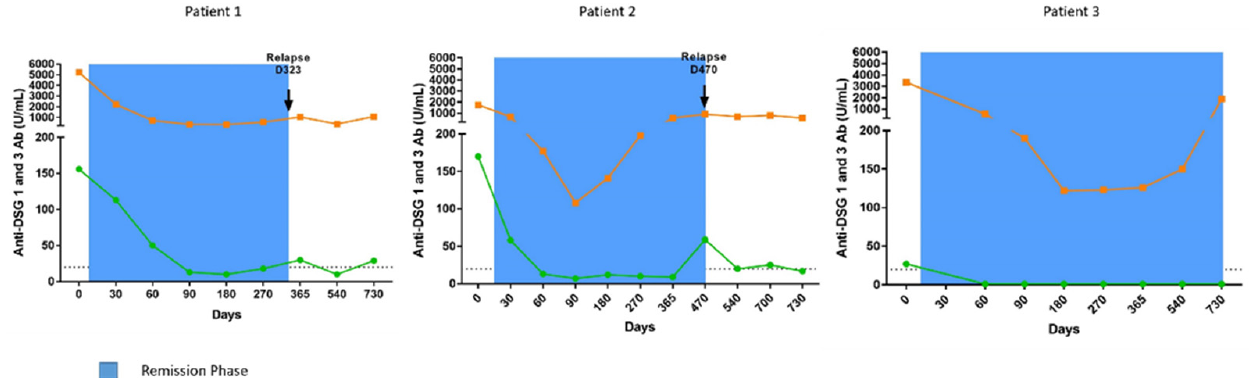
Figure 2. Evolution of anti-DSG1 (green) and anti-DSG3 (orange) antibody titers in sera from pemphigus patients treated with corticosteroids. Anti-DSG1 and anti-DSG3 IgG antibody titers were measured by ELISA. Dashed line represents the cut-off values proposed by the manufacturer for anti-DSG1 and anti-DSG3 antibody ELISA values. The remission phase is indicated in blue. The in vitro pathogenic activity of purified serum IgG was then tested by the follow- ing two different in vitro methods: the dispase-based dissociation assay, as described